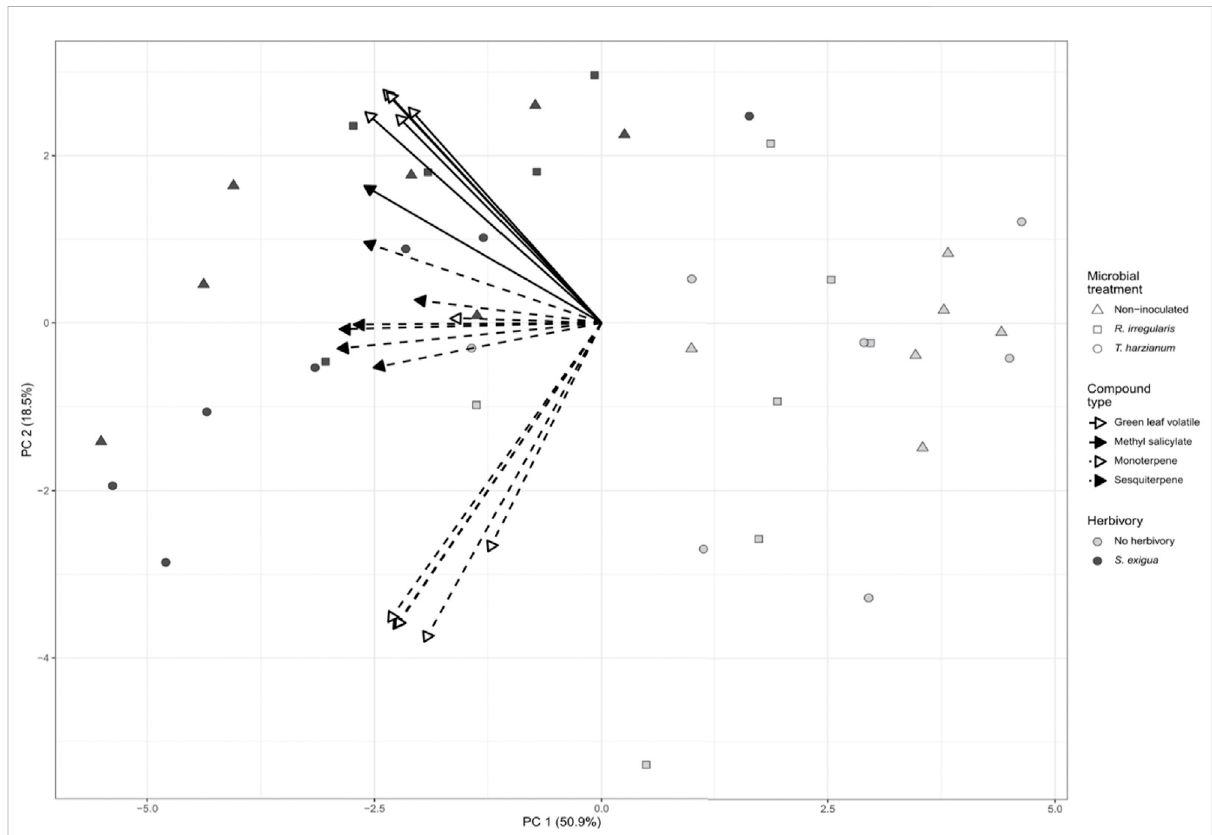
FIGURE 2 Principal component analysis (PCA) biplot describing the volatile emissions of non-inoculated (Nm), Rhizophagus irregularis -inoculated ( Rhi ), Trichoderma harzianum -inoculated ( Th )tomato plants non-infested or infested by Spodoptera exigua larvae for 24 h. Principal component analysis (PCA)wasperformedfor18selectedvolatilecompounds.Symbolsrepresentthebiologicalreplicateswithineachmicrobialtreatment:Nm(triangle); Rhi (square) Th (circle).Filledsymbolsrepresent S.exigua -infested plants,whereasnot fi lledsymbolsrepresentnon-infestedplants.Thearrows point to the volatile organic compound classes that contributed to the separation of the samples based on our targeted analysis. Continuous line arrows without a fi lled head point to the green leaf volatiles; with a fi lled head point to methyl salicylate. Perforated line arrows without a fi lled head point to monoterpenes; with a fi lled head point to the